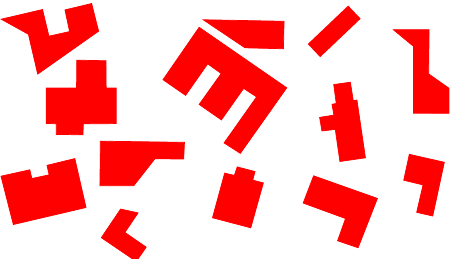
Figure 7. Input map for algorithm. Preprocessed picture of area to be investigated by